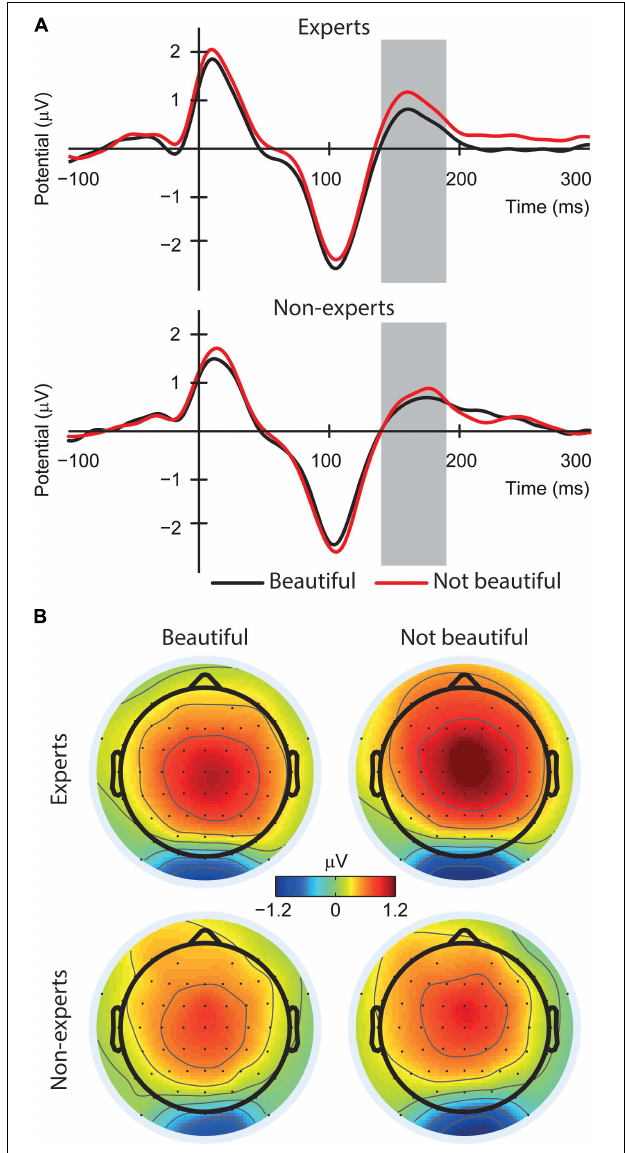
FIGURE 5 | (A) The interaction effect of expertise and aesthetic judgment on the frontal P2 amplitude (averaged from F3, Fz, F4 electrodes) in the focal mode (the frontal P2 time window is indicated by the gray field). (B) Topographic maps of fixation onset – related brain activity in the 140–190 ms time window (focal